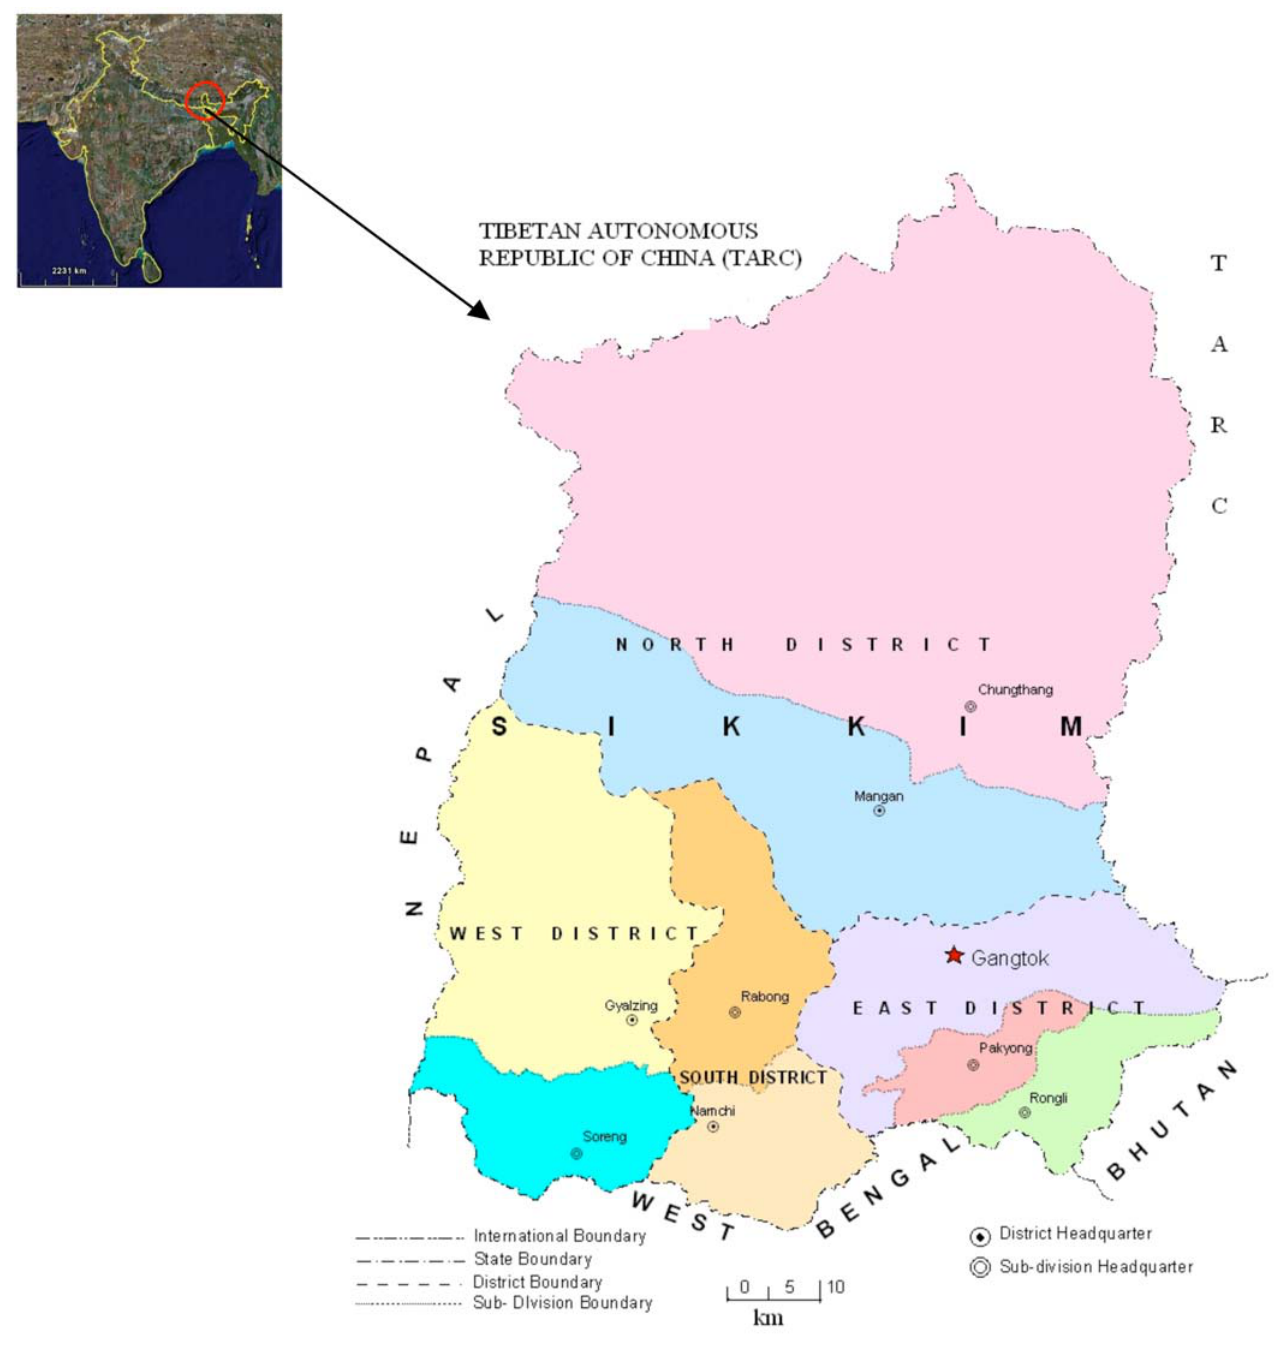
Image 1. Map of Sikkim showing its prominent